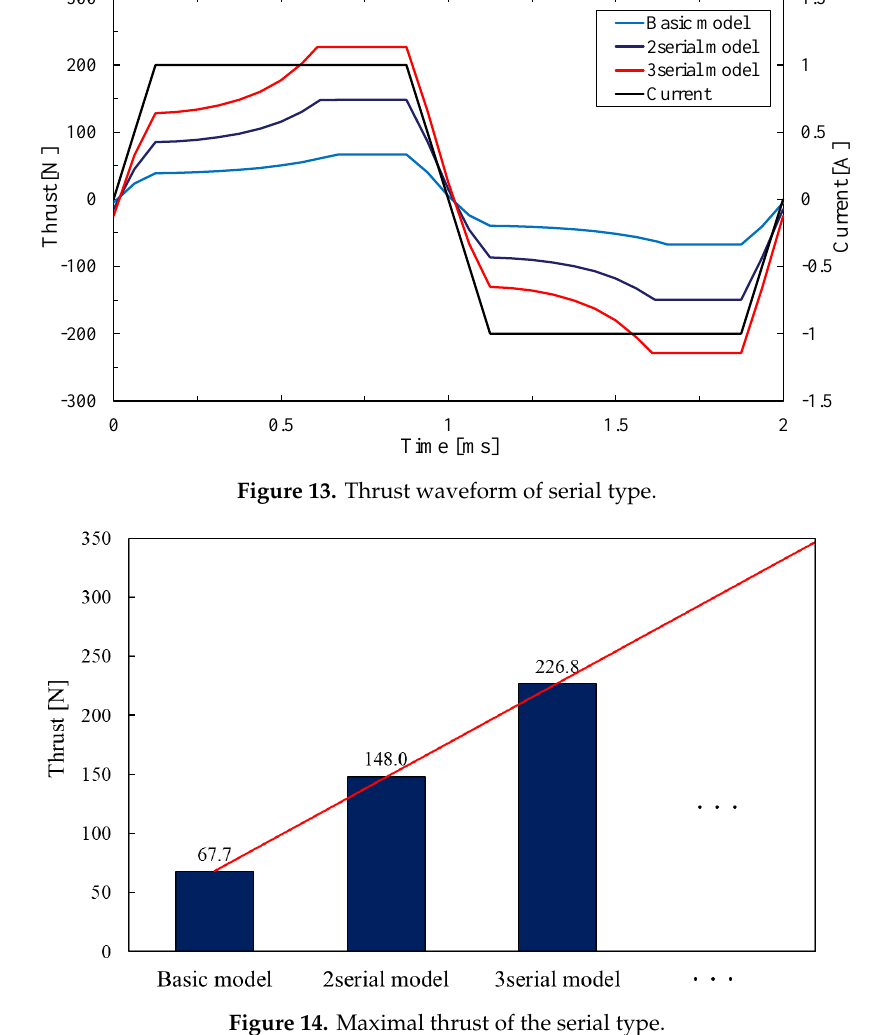
Figure 14. Maximal thrust of the serial type.